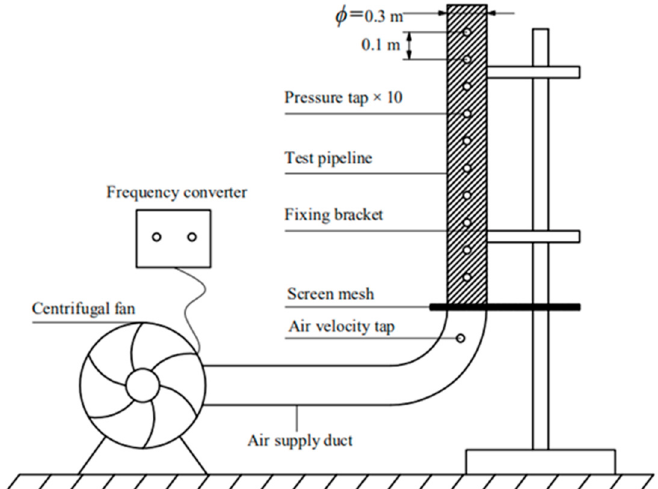
Figure 1. The schematic diagram of the laboratory-scale experimental apparatus. Table 1. The details of the instruments used for the tests.